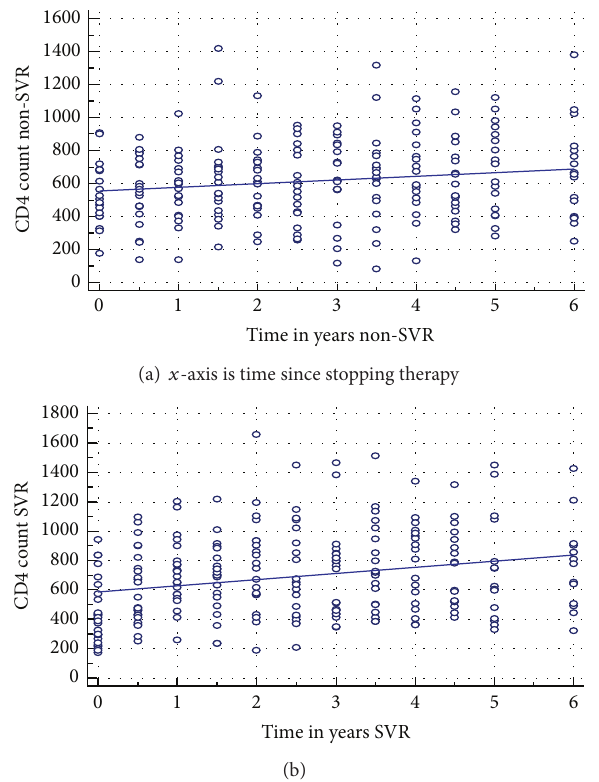
Figure 1: Scatter plots demonstrating the average of CD4 T cell countsforsubjectsovertimeinyearsfornonspontaneousvirological responders (a) and spontaneous virological responders